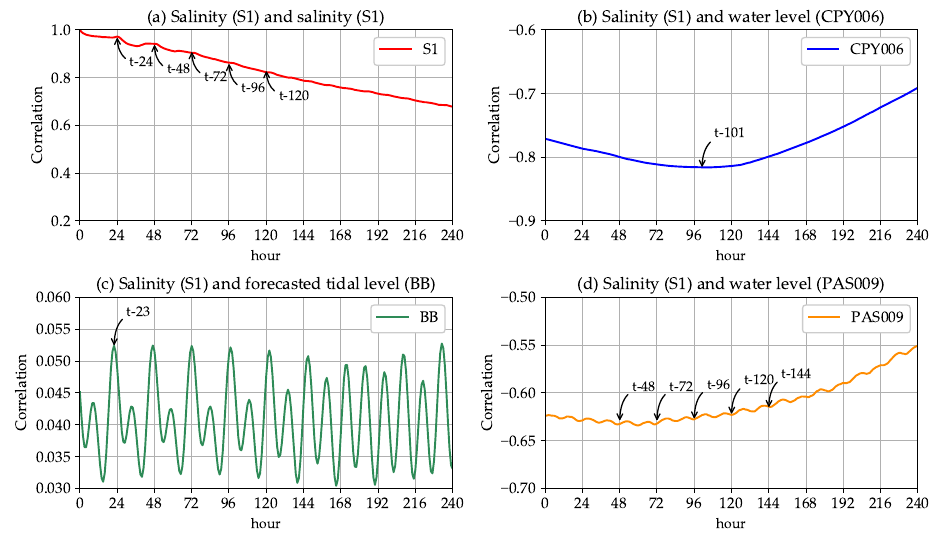
Figure 4. The cross-correlations between S1 and various variables for the high water level case: ( a ) the auto-correlation of S1; ( b ) the cross-correlation between S1 and CPY006; ( c ) the cross-correlation between S1 and BB; and ( d ) the cross-correlation between S1 and PAS009.